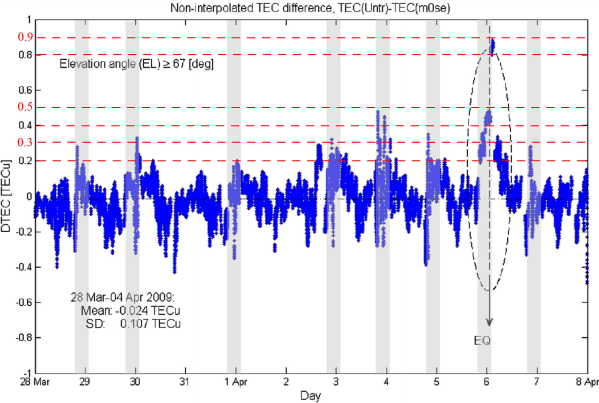
Figure 2. VTEC difference DTEC = TEC UNTR − TEC M0SE from all satellites crossing central Italy with an elevation angle greater than 67 ◦ as reported by Nenovski et al. (2015, Fig. 10a). EQ refers to the 6 April 2009 main shock. The dashed ellipse highlights the hump-like variation in DTEC during 5–6 April 2009 that according to Nenovski et al. (2015), may be related to the earthquake. Note that DTEC clearly shows a diurnal variation throughout the investi- gated period. The shadowed areas (that we have superimposed onto the original view) highlight DTEC maxima that, as for 5–6 April, occur in the same night period. EQ identifies the 6 April 2009 main